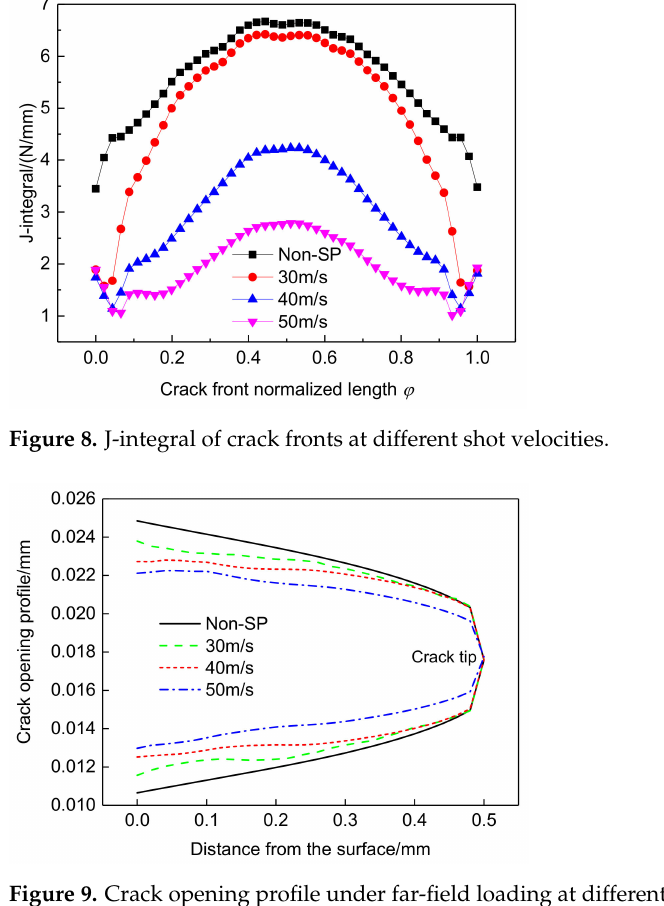
Figure 9. Crack opening profile under far-field loading at different shot velocities.